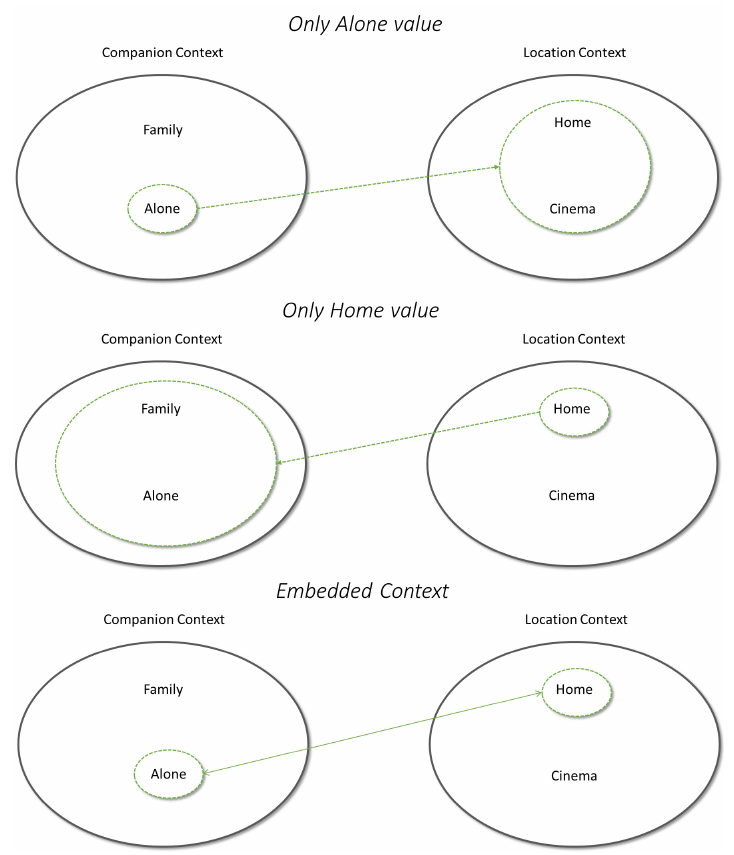
Figure 2. Summary of the embedded context idea based on the example